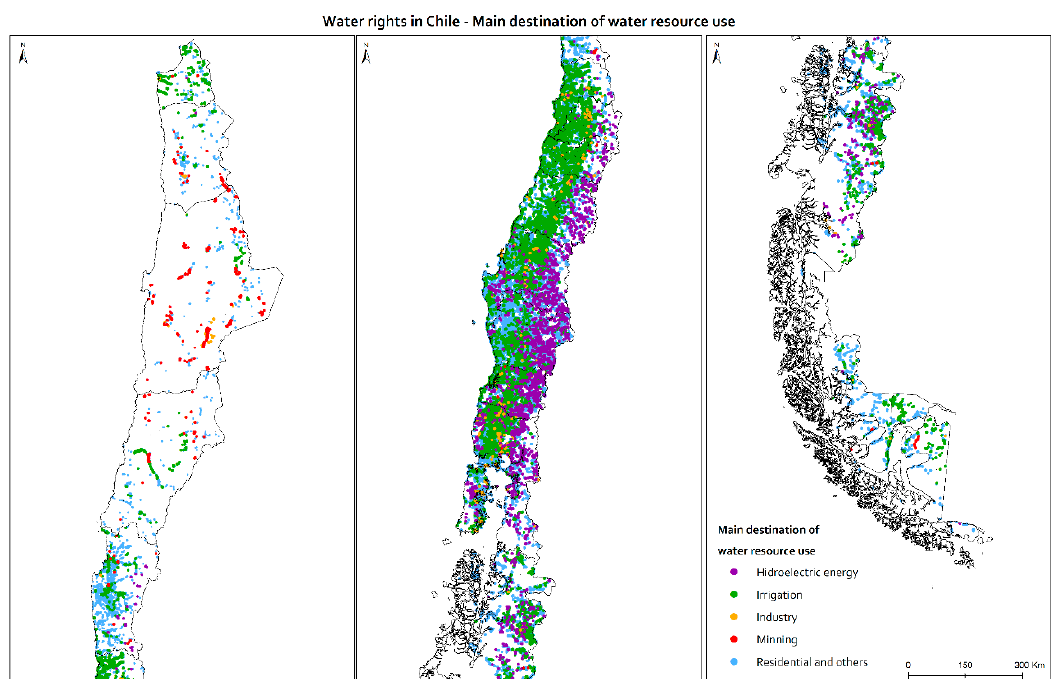
Figure 3. Water rights according to the main destination of water use. Source: Author’s elaboration according to DGA data.